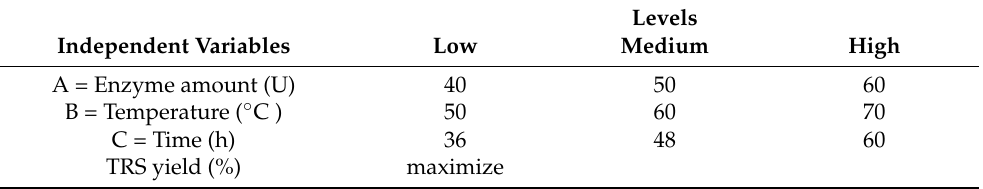
Table 2. Variables of enzymatic hydrolysis in the Box–Behnken